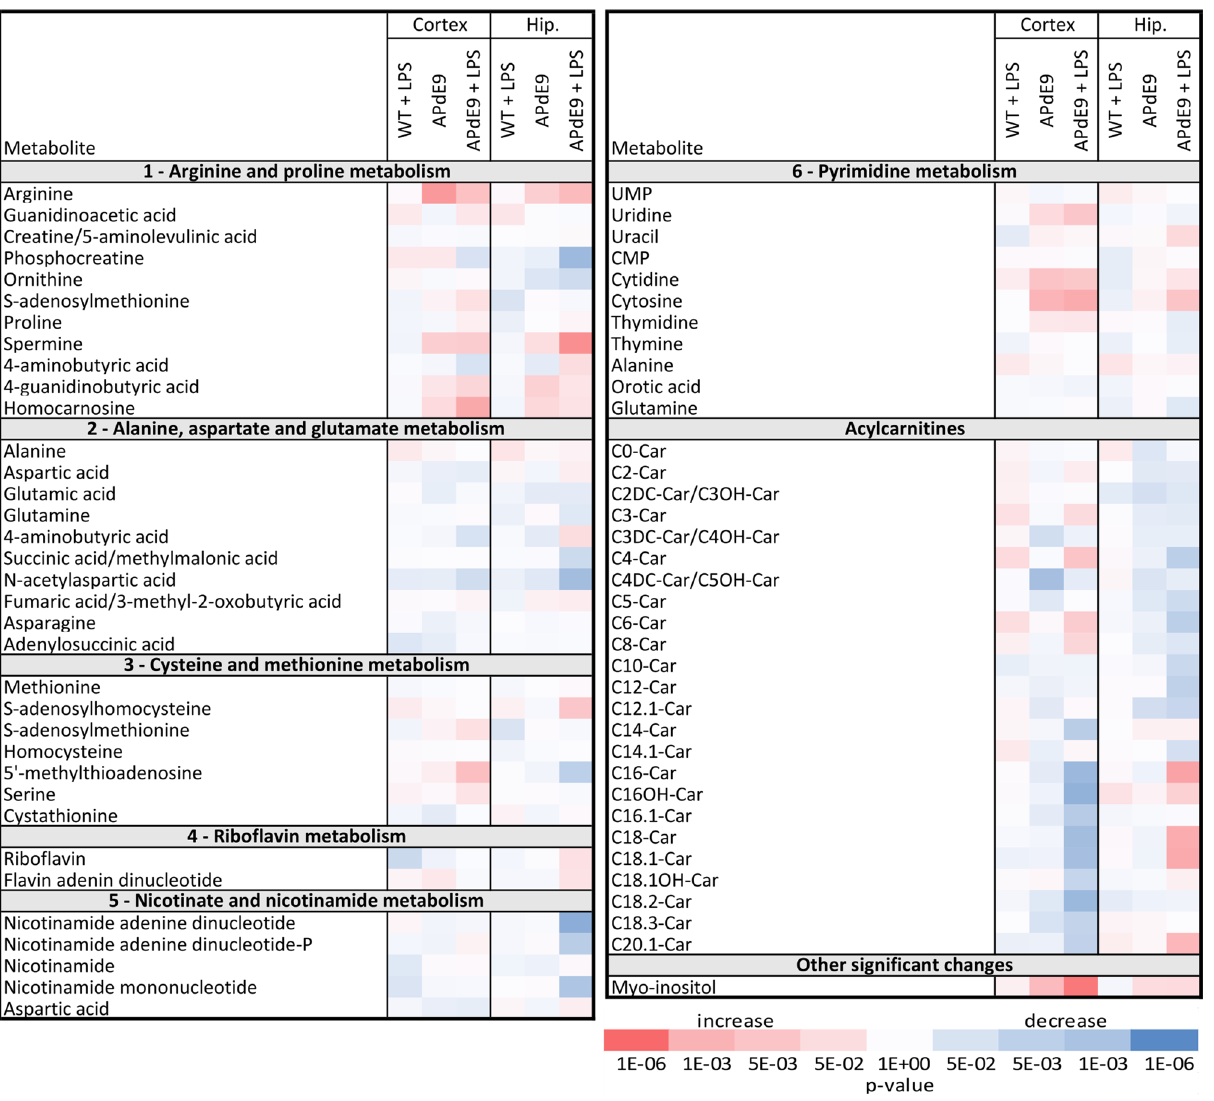
plus LPS (n = 9) groups versus WT control (n = 11). Heatmap of p values without correction, − log10 scaled: red—increased metabolites (fold-change > 0), blue—decreased metabolites (fold-change < 0). The statistical significance on the level of 0.05 after Bonferroni correction was calculated as a p value < 3.23 × 10 −4 . Details of the metabolites are provided in Supplementary Table S1